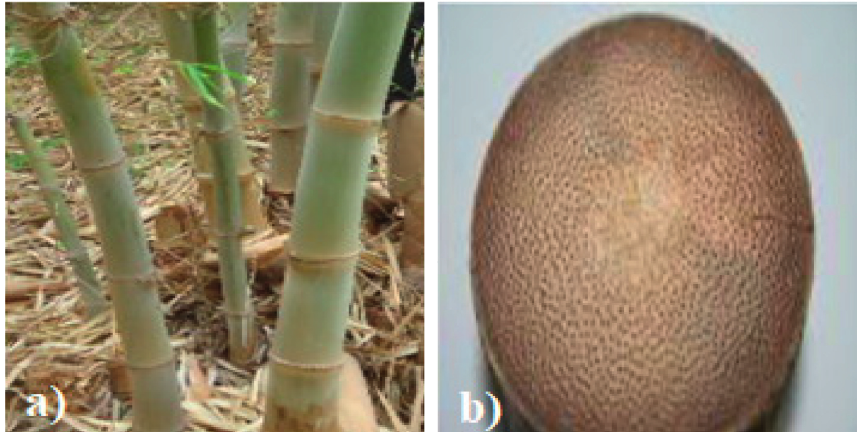
Figure 10: O. abyssinica standing culms (a) and thick and solid culms after maturation (b).